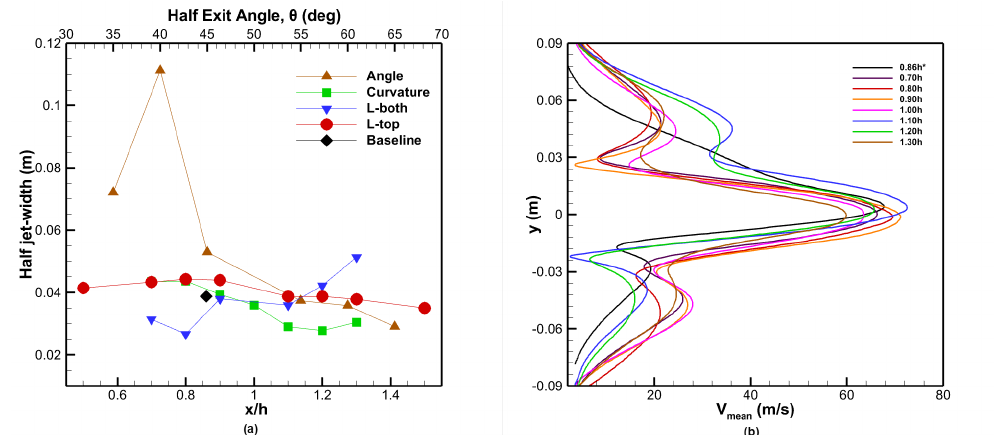
Figure 11. At x/h = 5, ( a ) half-jet width for curvature, L-top and L-both cases (in terms of nozzle length, x/h) and angle case (in terms of the half-exit angle, θ ). ( b ) Velocity profile for the curva- ture case.